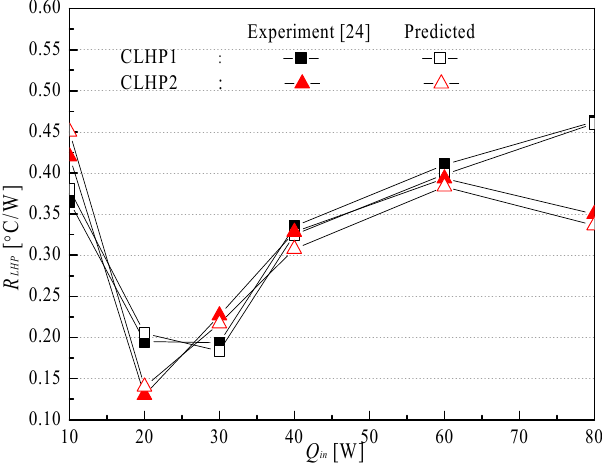
Figure 5. Comparison between thermal-resistance values based on the temperature data reported in ref. [24] and those obtained using the steady-state analytical model.